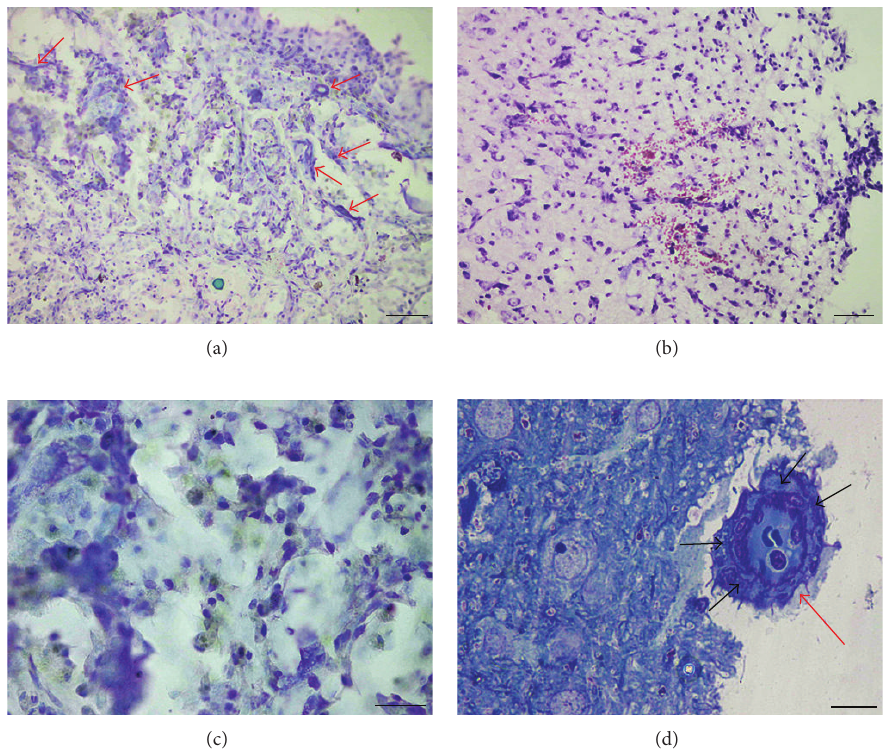
Figure 6: Morphological characteristics of group 4. (a) Group 4: infiltrate. Numerous cells of infiltrate and newly formed vessels. Arterioles are marked with arrows. (b) Group 4: penumbra. Extravasate formed by separated erythrocytes at the boundary between the penumbra and infiltrate. (c) Group 4: infiltrate. Macrophages with pale and stained granules. (d) Group 4: penumbra. Newly formed blood vessel is marked with a red arrow, and macrophages in the vessel wall are marked with black arrows. Hypertrophied vessel wall containing macrophages with dark cytoplasm. Semi-thin section. The scale bars are 100 𝜇 m in (a) and (b), 30 𝜇 m in (c), and 20 𝜇 m in